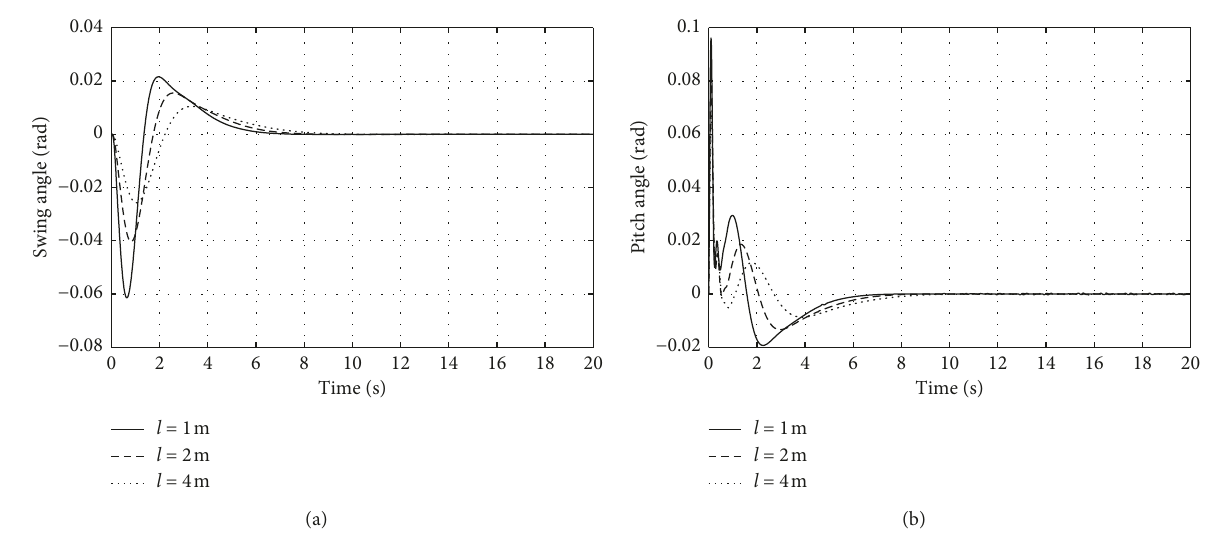
Figure 4: Swing and pitch